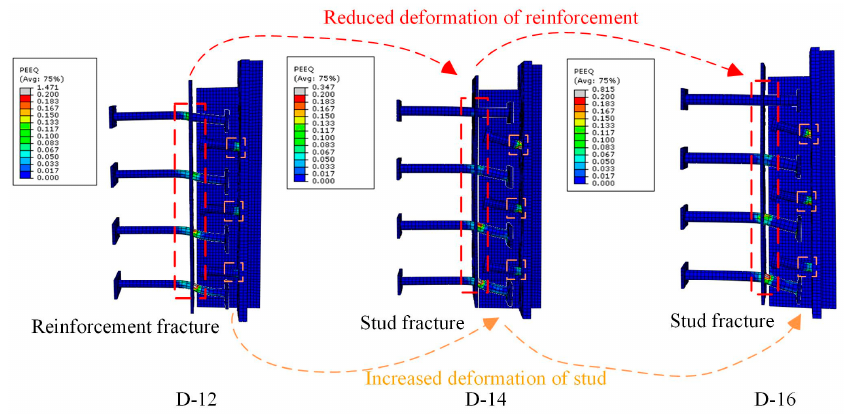
Figure 26. Damage results of studs and shear